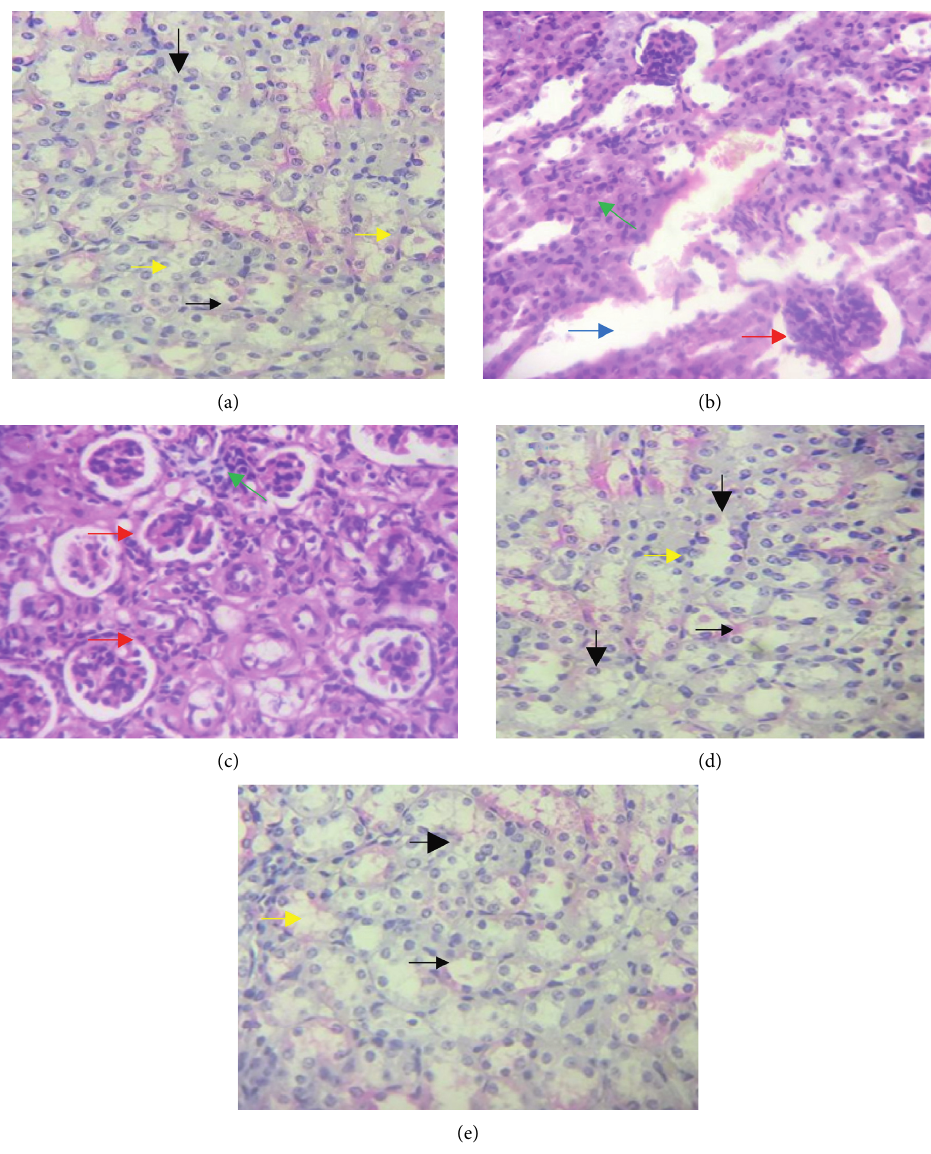
Figure 3: (a) Photomicrograph of kidney of experimental animals (stained with hematoxylin and eosin), where normal proximal tubule (thick arrow), normal distal tubule (thin arrow), and normal glomerulus (yellow arrow) are shown. (b) Photomicrograph of kidney of experimental animals (stained with hematoxylin and eosin), where fibrosis (blue arrow), necrosis (red arrow), and inflammatory infiltration (green arrow) are shown. (c) Photomicrograph of kidney of experimental animals (stained with hematoxylin and eosin), where necrosis (red arrow) and inflammatory infiltration (green arrow) are shown. (d) Photomicrograph of kidney of experimental animals (stained with hematoxylin and eosin), where normal proximal tubule (thick arrow), normal distal tubule (thin arrow), and normal glomerulus (yellow arrow) are shown. (e) Photomicrograph of kidney of experimental animals (stained with hematoxylin and eosin), where normal proximal tubule (thick arrow), normal distal tubule (thin arrow), and normal glomerulus (yellow arrow) are